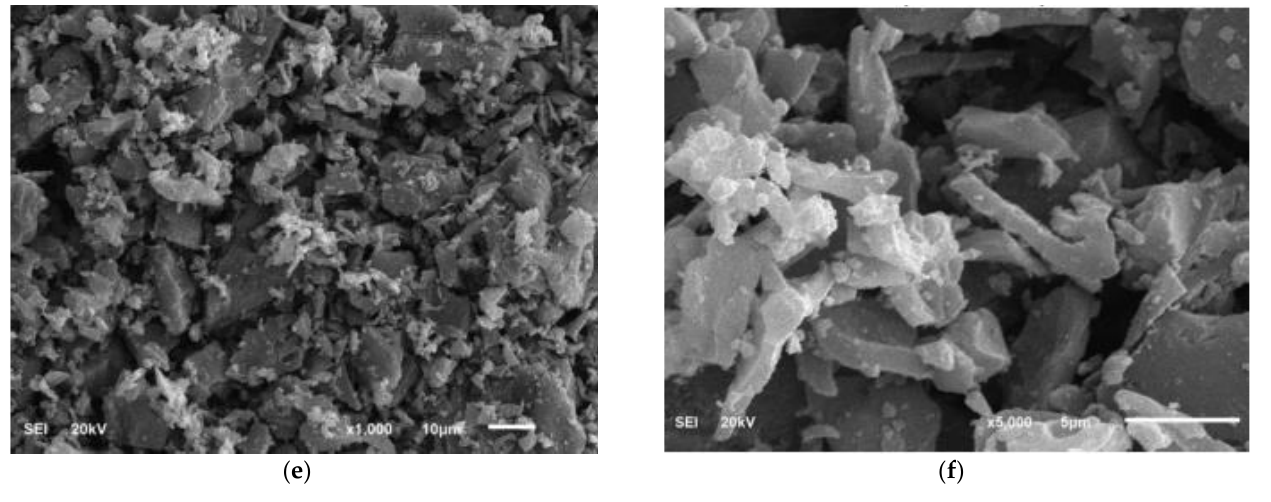
Figure 7. SEM image of natural pozzolan, raw kernel powder, and burnt kernel ash DKA. ( a ) Natural pozzolan (NP) at 10 µ m; ( b ) natural pozzolan (NP) at 5 µ m; ( c ) raw kernel (RK) powder at 10 µ m; ( d ) raw kernel (RK) powder at 5 µ m; ( e ) date kernel ash (DKA) at 10 µ m; ( f ) date kernel ash (DKA) at 5 µ m. Table 3. Concrete mix